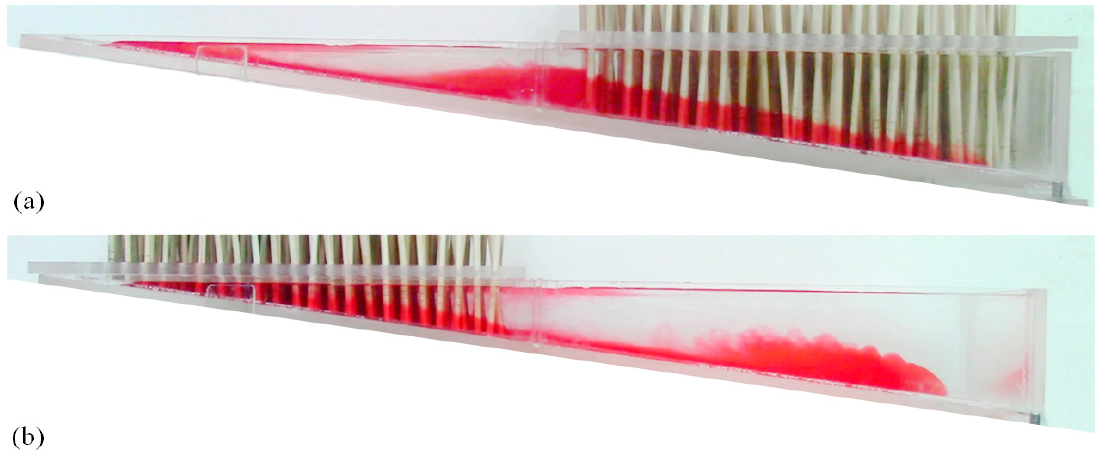
Figure 4. Images of gravity currents for two different configurations: ( a ) open water in shallows and a model canopy in deeper regions (Run 34); and ( b ) a model canopy in shallows and open water in deeper regions (Run 33).